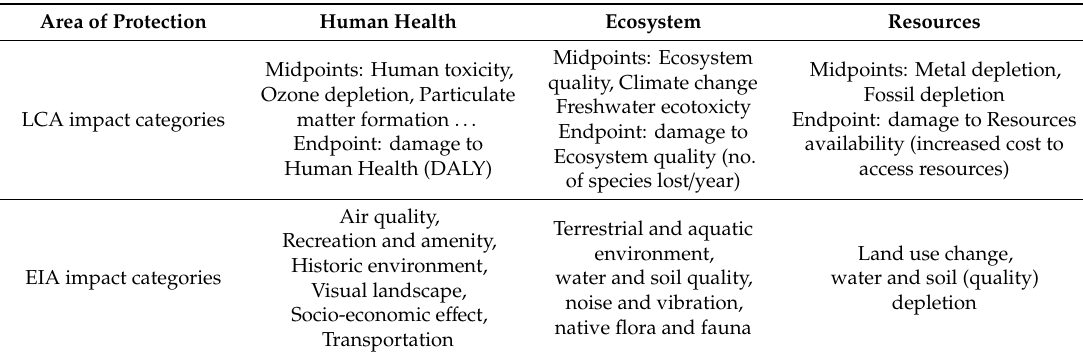
Table 1. Mapping of the LCA midpoint categories, endpoint categories, and the EIA impact categories to area of protection. Source: Own study interpretation.